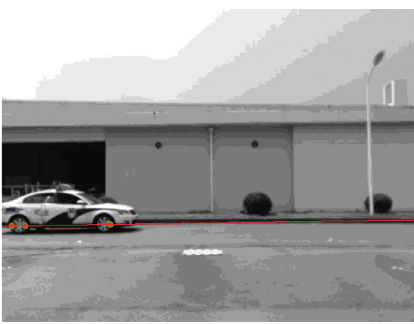
Figure 6: Three feature points calibrated on vehicle exterior